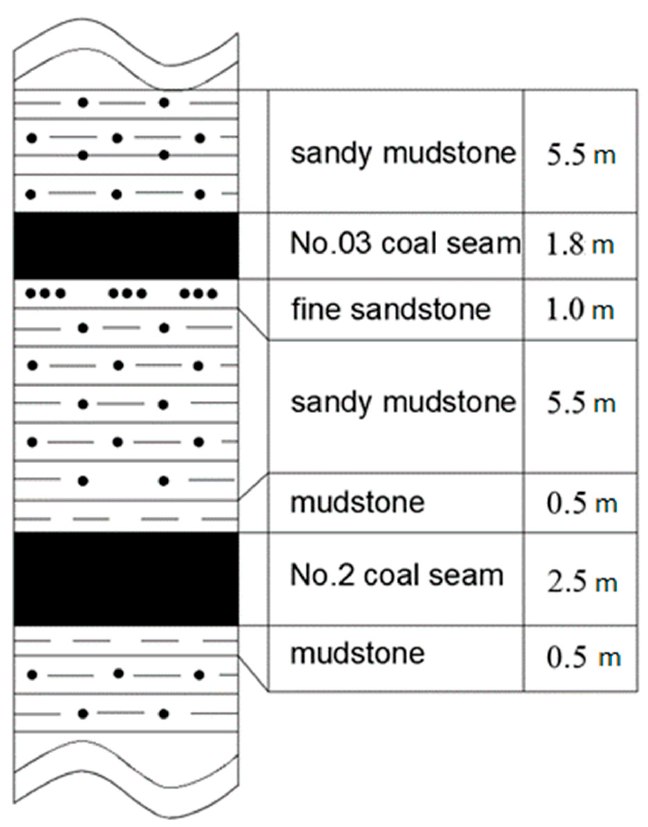
Figure 9. Horizon structure of coal seams No.3 and No.2. The calculation formula of the “Regulations on Coal Mine Water Hazard Control- ling” for the thickness of the safe water-resisting layer in the heading face is shown in Equation (1):